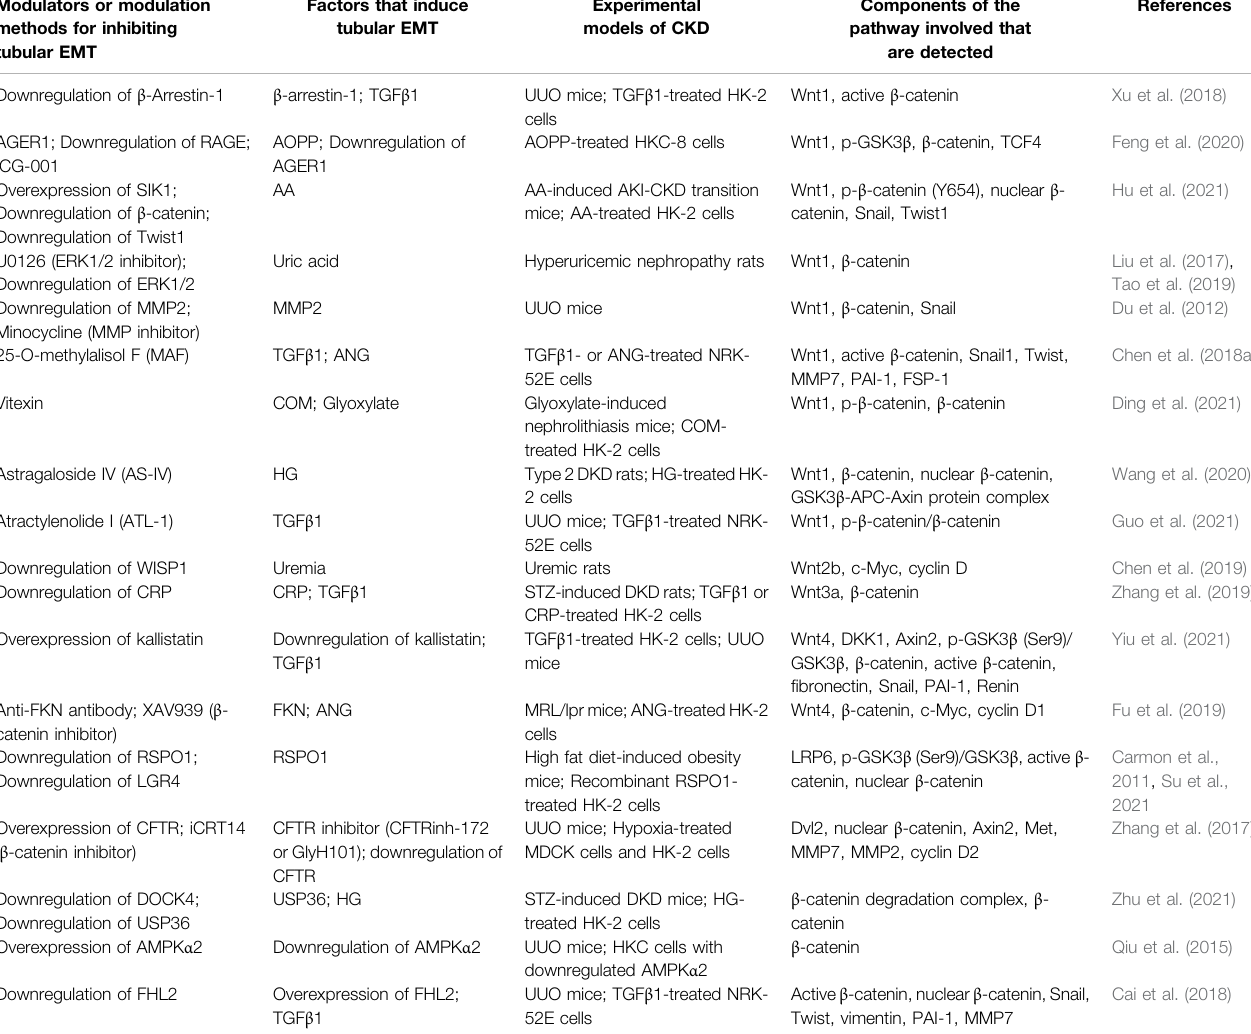
TABLE 1 | Potential modulations for inhibiting EMT and components of Wnt/ β -catenin pathway involved. Modulators or modulation methods for inhibiting tubular